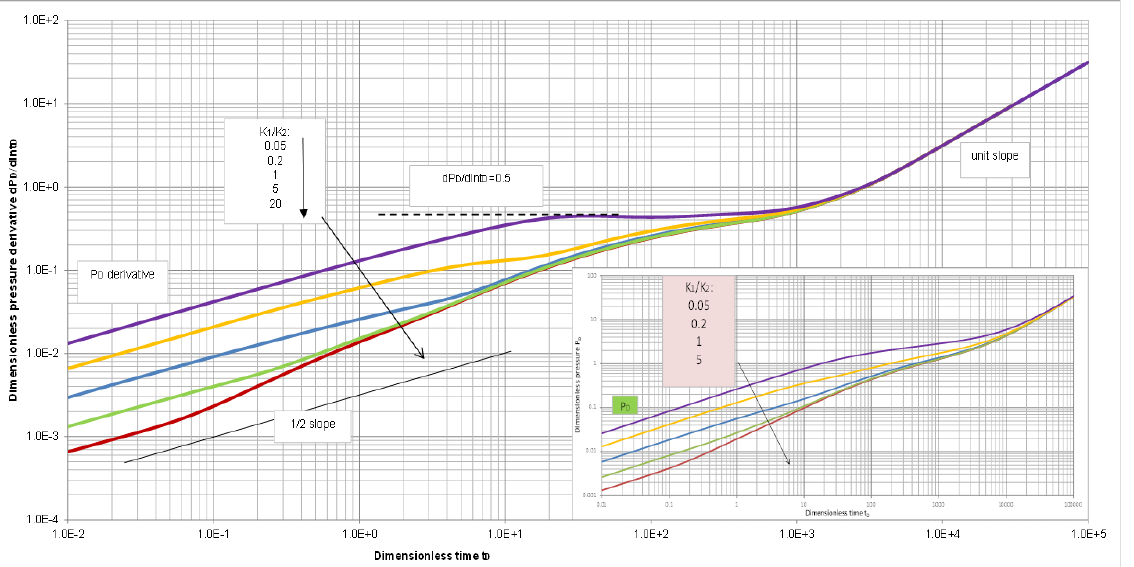
Figure 19. Pressure and its derivative behaviors of a fractured, horizontal well under a different permeability ratio 𝑘 1 /𝑘 2 , with 2𝐿 𝑓𝐷 /𝑌 𝑒𝐷 = 0.1 , 𝑤 𝑠𝑟𝑣𝐷 /𝑑 𝑓𝑠𝐷 = 0.5 , 𝑋 𝑒𝐷 = 200 , and 𝑌 𝑒𝐷 = 100 .